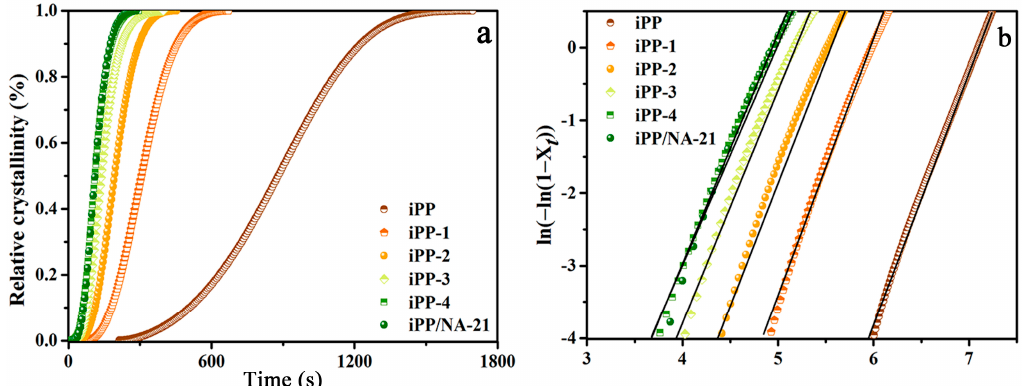
Figure 7. The relative crystallinity curves ( a ) and the relation of ln [ − ln (1 − X t )] versus lnt ( b ) for the iPP/A12C-Li composites. Table 2. The isothermal crystallization parameters for the iPP/A12C-Li composites. Samples